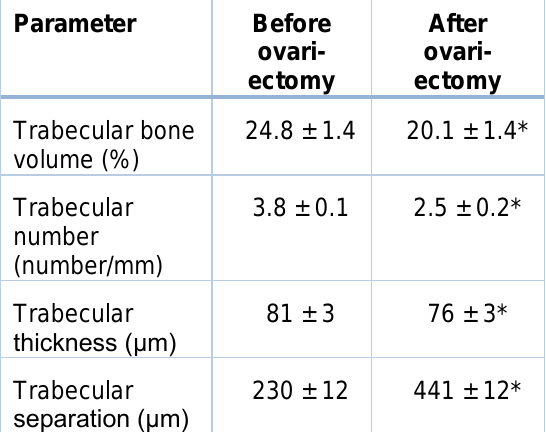
Table 3: Verification of osteoporosis in rats Parameter Before